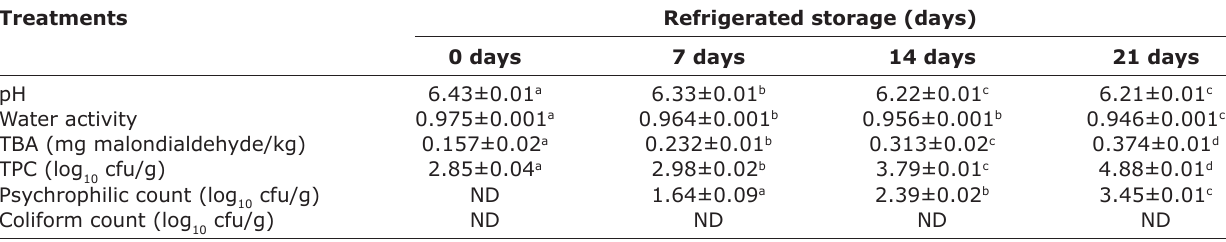
Table-3: Physicochemical and microbiological characteristics of meat spread at refrigeration temperature (mean±SE)*. Treatments